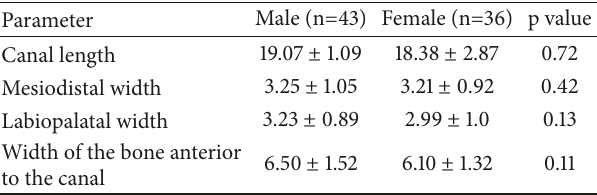
Table 3: Comparison of incisive canal characteristics between male and female